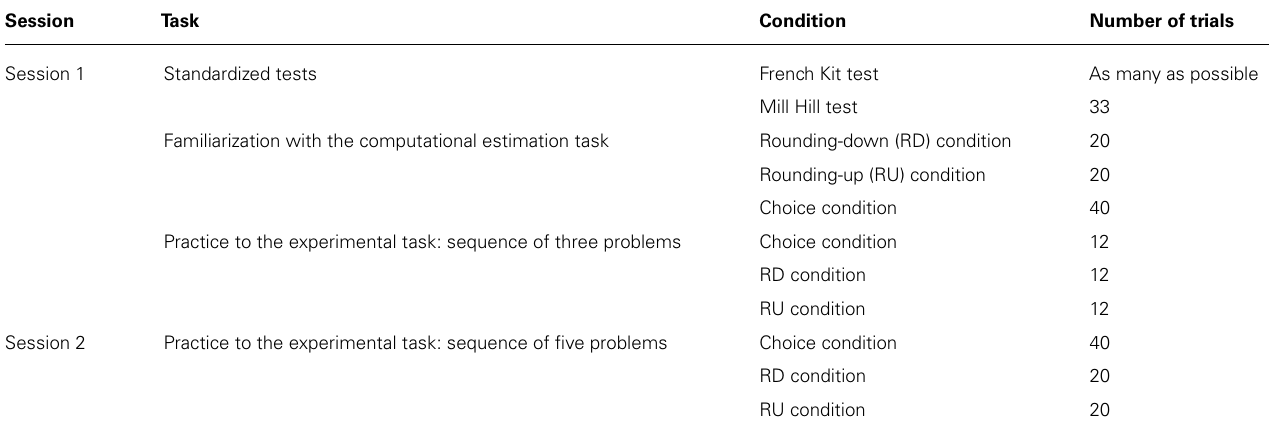
Table 1 | Summary of the